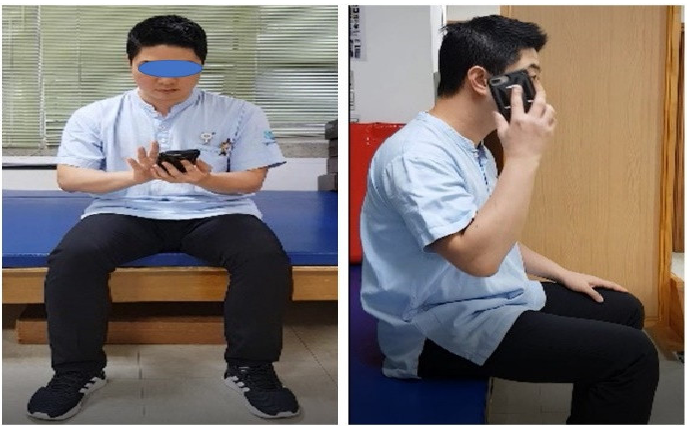
Figure 2. One of ten activities in AO + MI interventions. (ex: using a mobile phone).